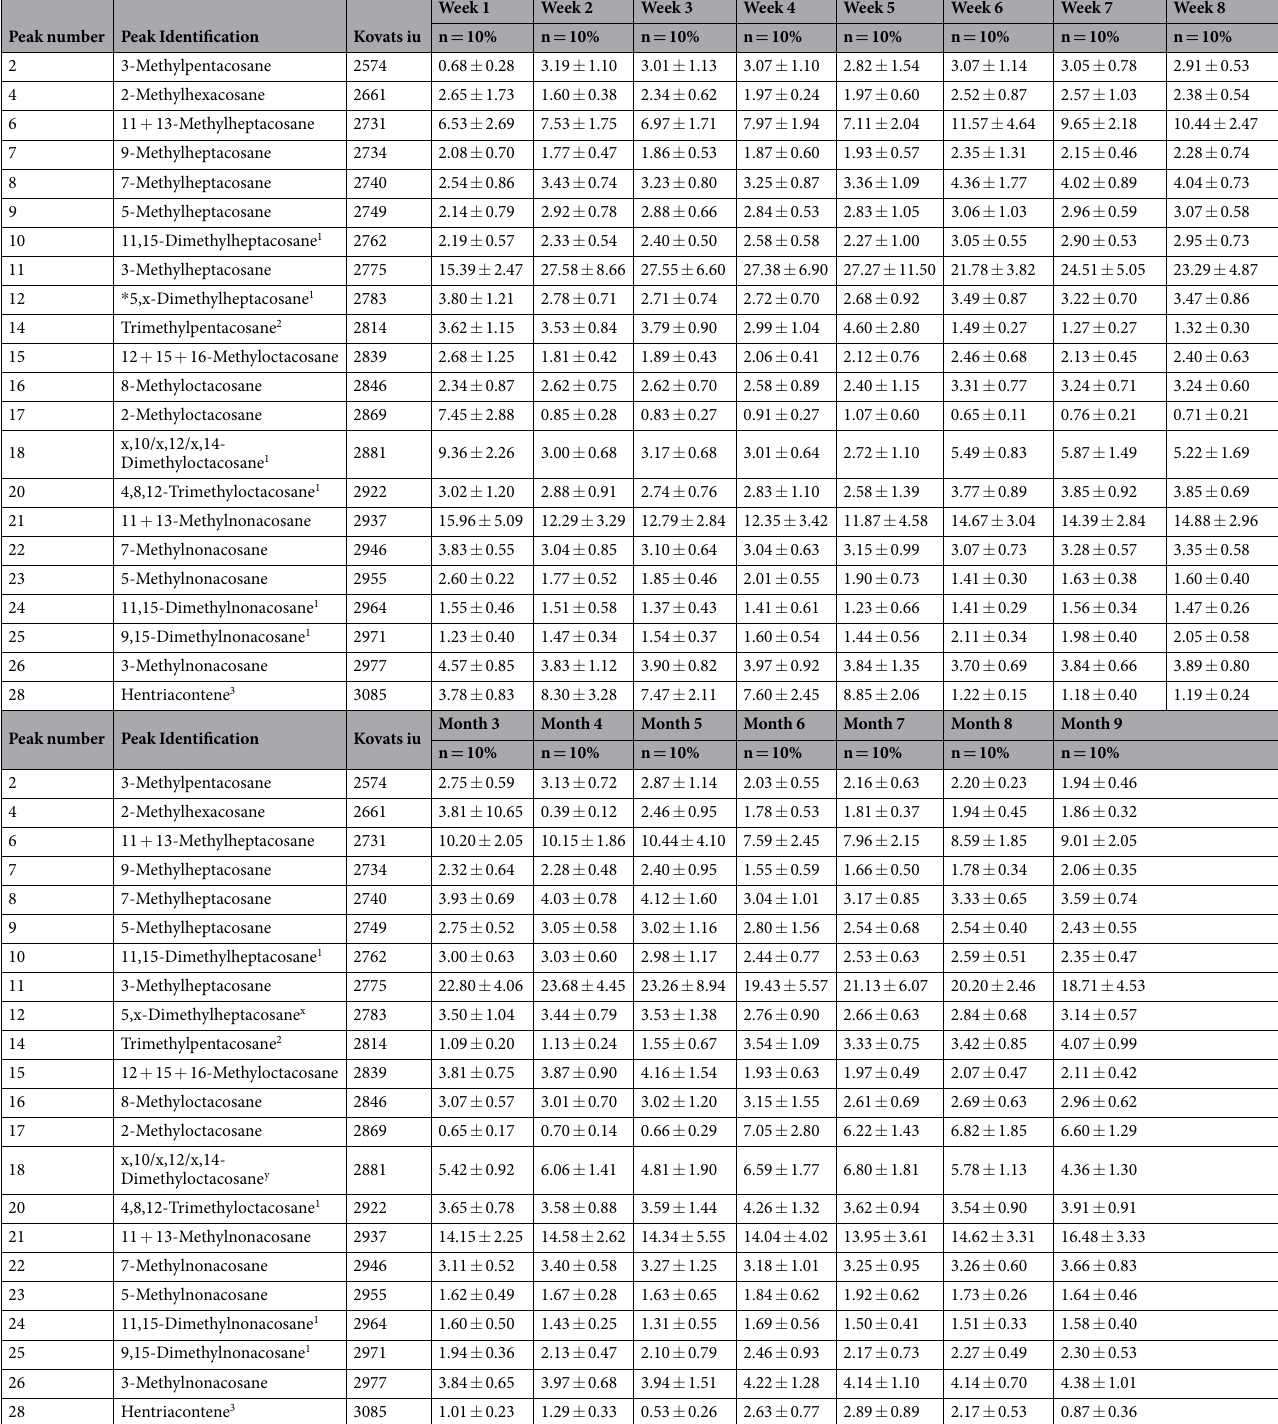
Table 4. List of the compounds extracted and used for subsequent multivariate analysis from the puparial cases of C . vicina , with the total percentage of each compound present, the percentage standard deviation for each week/month and the Kovats Indies to aid identification. 1 Tentative identification based on Kovats Index. 2 Methyl branch position not determined. 3 Double bond positions only determined for adult flies. x x = 9, 11, 15. y x = methyl branched position not